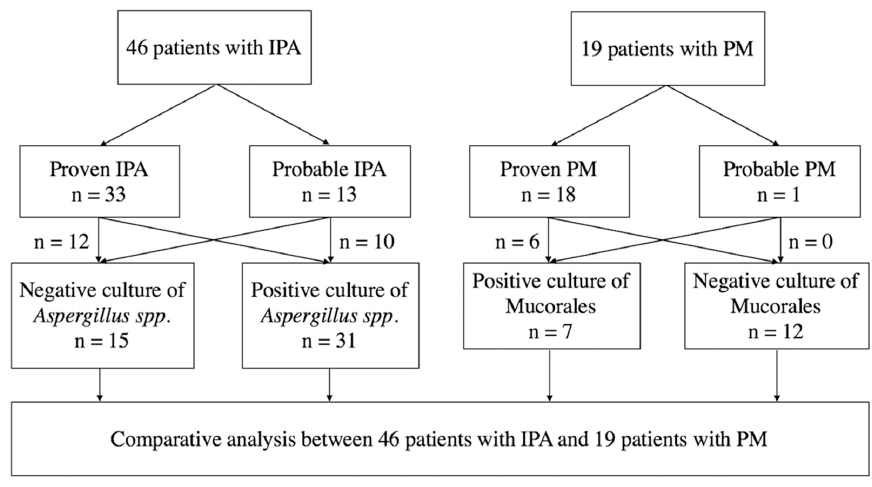
Figure 1. Schematic flow chart of the study. IPA, invasive pulmonary aspergillosis; PM, pulmonary mucormycosis. Table 1. Comparison of clinical characteristics, treatments, and outcomes between IPA and PM.